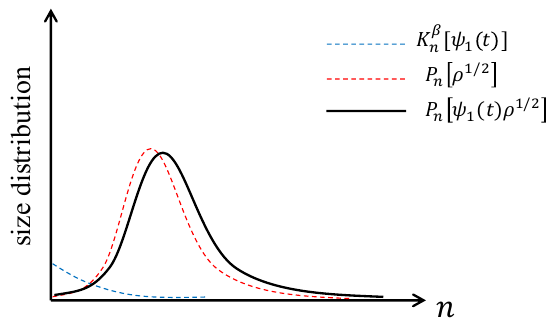
(cid:2) 1 = 2 (cid:3) for the operator 1 = 2 1 ( t ) (cid:26) 1 ( t ) (cid:26) [ 1 ( t )] n (cid:2) (cid:3) (cid:26) 1 = 2 of the operator (cid:26) 1 = 2 (red dashed curve).